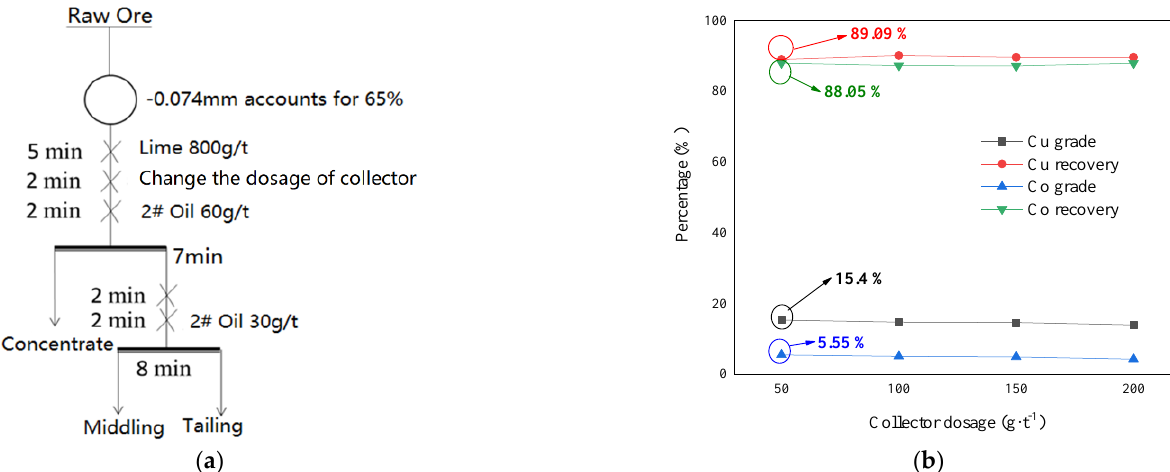
Figure 8. Effect of collector dosage on the recovery of sulfide aggregates. ( a ) The flow chart for flotation experiments ( b ) Effect of collector dosage on the flotation recovery.